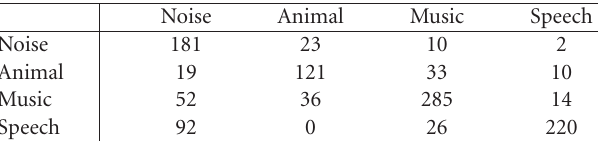
Table 5: Confusion matrix (rows give the decision and columns give the true class) for AM short with GMM. This gave an accuracy of 71.79%.